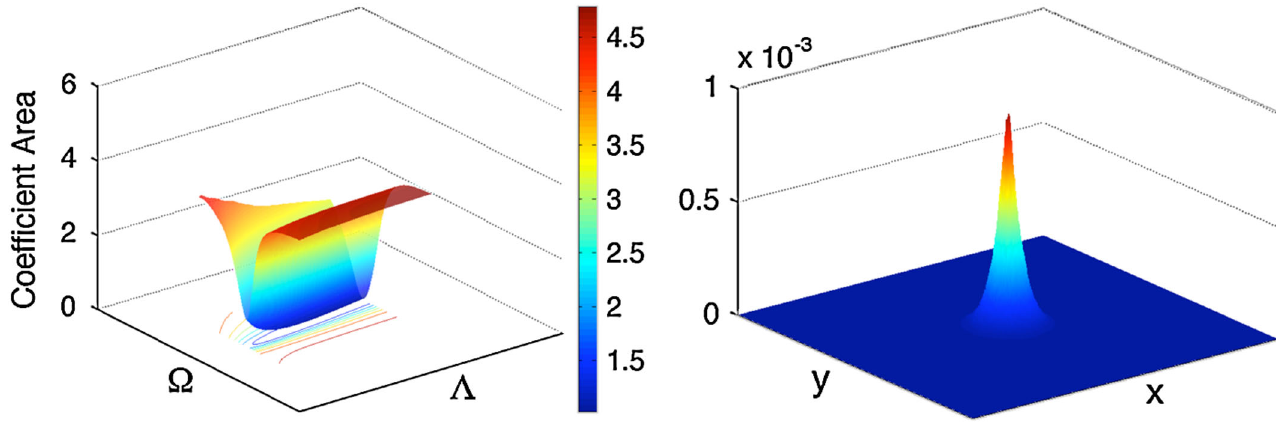
5. (Color) The left side is the coefficient area map of the LANL linear taper system with (cid:1) 3 (cid:3) (cid:7) (cid:1) (cid:7) 3 (cid:3) and 1 : 0369 (cid:7) (cid:2) (cid:7) 10 : 3694 . On the right is the normalized light intensity pattern at the undulator exit. Intensity is in arbitrary units. Transverse dimension in dimensionless units is (cid:1) 6 : 0302 (cid:7) x (cid:7) 6 : 0302 and the same for y .